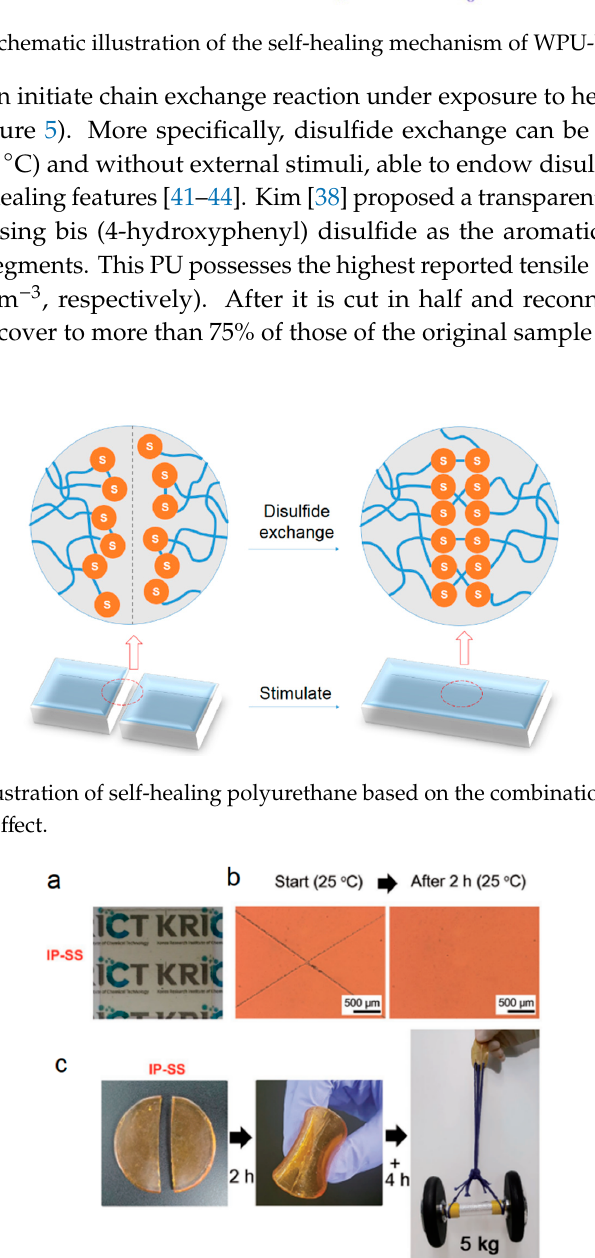
Figure 6. ( a ) Photograph of the TPU film (25 mm × 25 mm × 0.3 mm) of IP–SS. ( b ) Optical microscopy images of the X-shaped scratch on the TPU film of IP–SS before and after healing for 2 h at 25 °C. ( c ) IP–SS film cut in half, respliced, and healed for 2 h (+4 h) at 25 °C, followed by a 5 kg dumbbell lifting test [45].